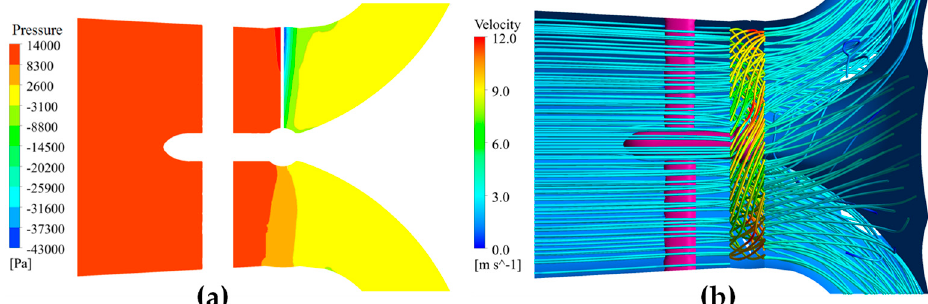
Figure 13. Flow pattern in the WTP at BEP: ( a ) static pressure distribution in the vertical section of turbine and ( b ) 3D streamline in the turbine.